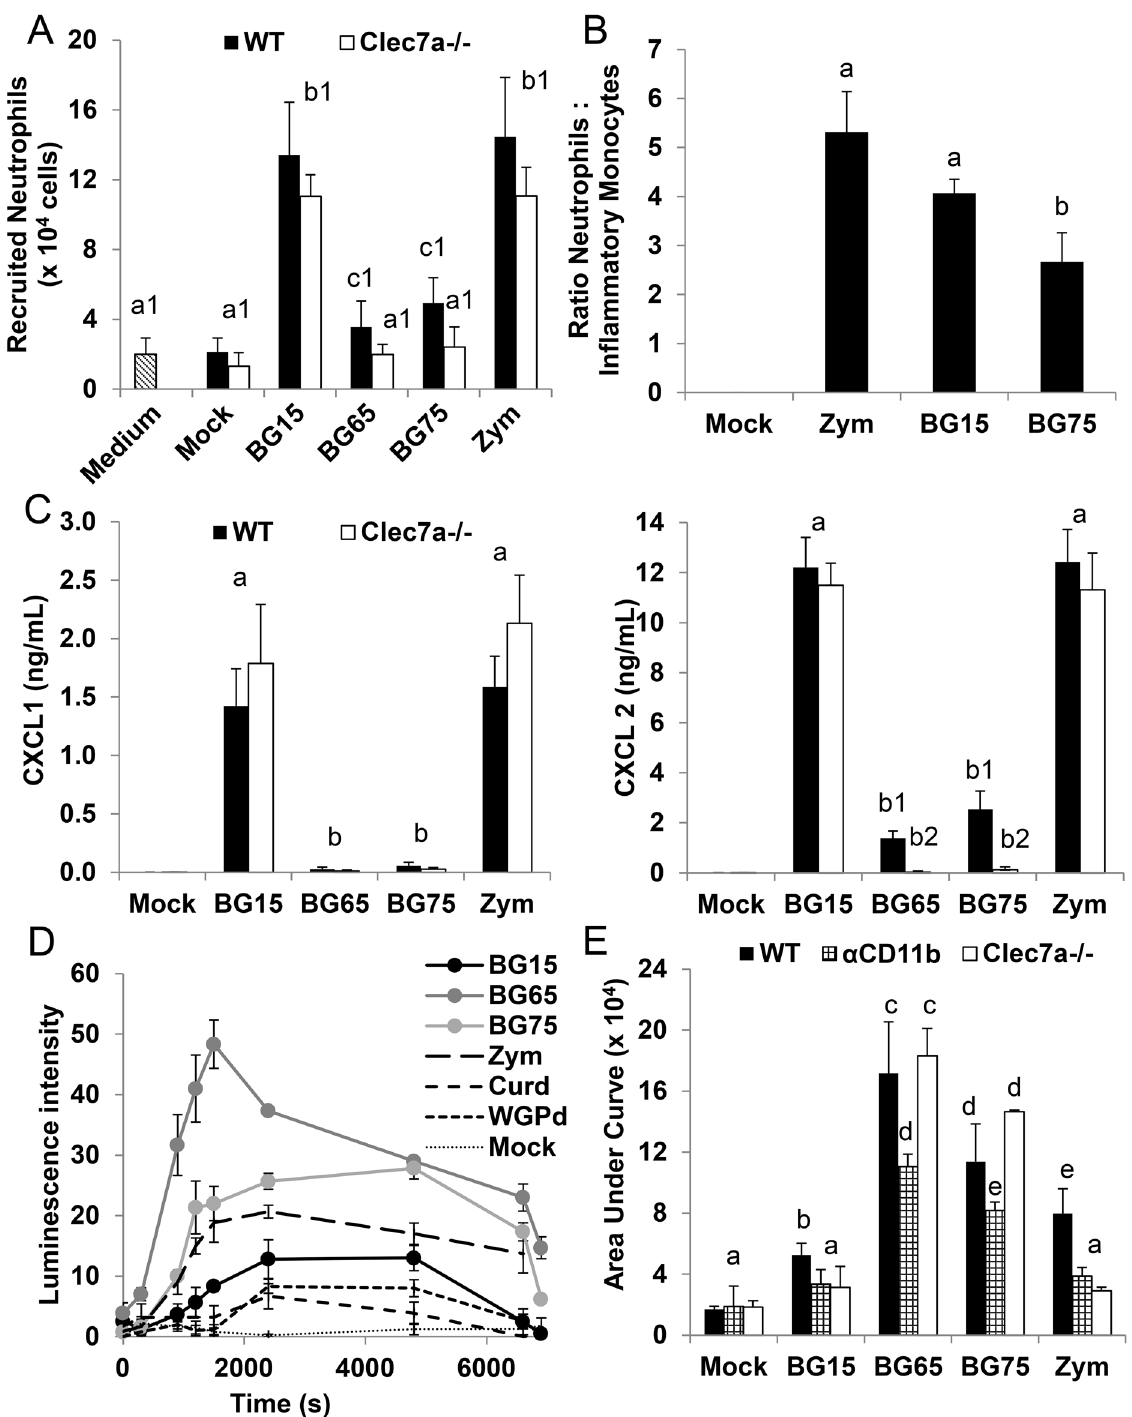
Fig 7. Sc BG-enriched extracts poorly induce neutrophil recruitment via dectin-1 but strongly stimulate ROS production via CR3 and not dectin-1. (A) Transwell chemotaxis assay to assess the chemotactic activity of supernatants from WT and Clec7a -/- BMDM stimulated with Sc BG extracts (BG15, BG65 and BG75) for 8 h. BM neutrophils of WT C57Bl/6 mice (5x10 5 cells/well) were incubated for 30 min at 37°C with the supernatants and the neutrophils migrating into the lower chamber of the 96-well transwell plate were quantified by flow cytometry with an absolute counting system. Control wells